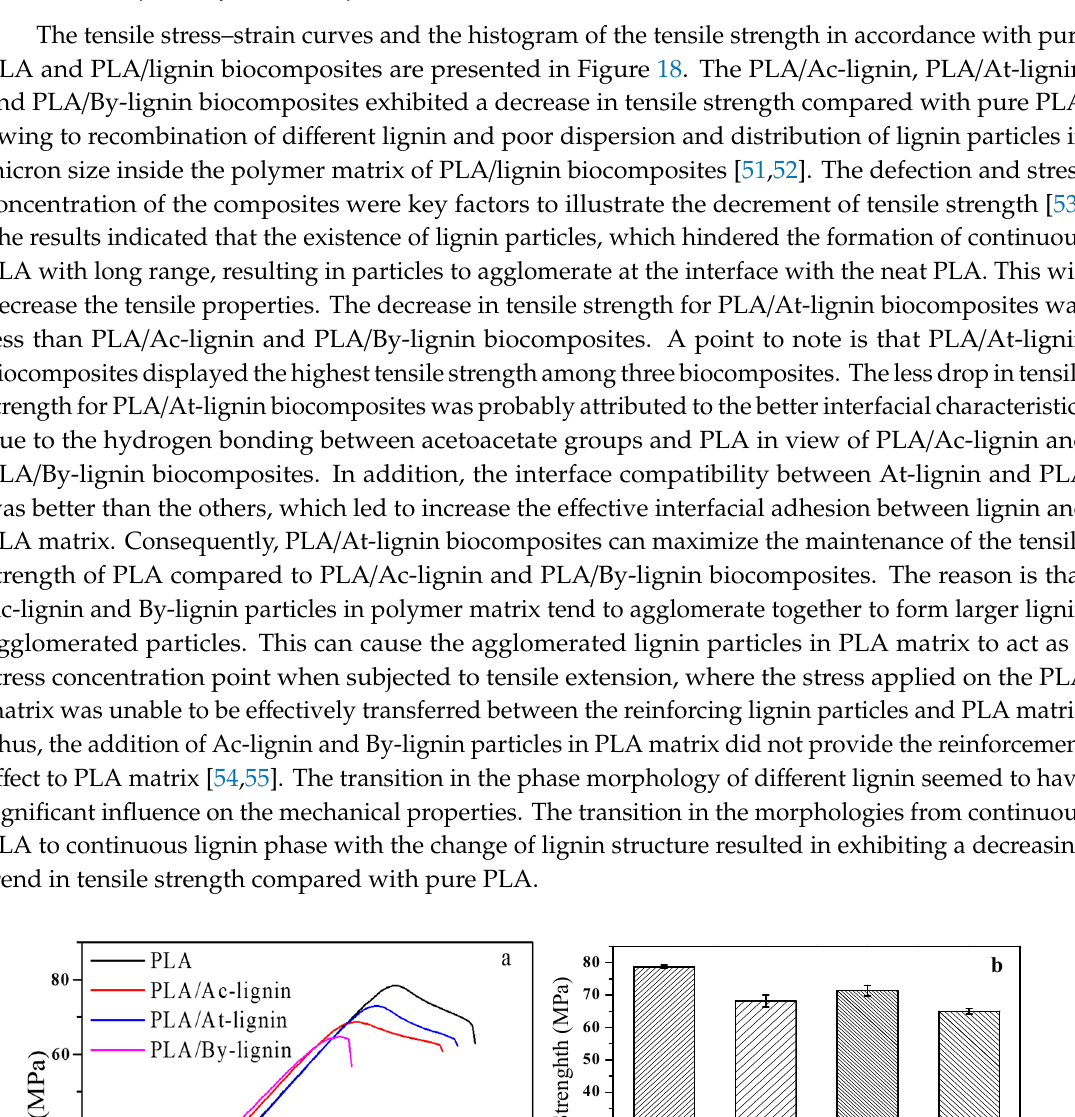
Figure 17. Temperature ramp sweep curves for pure PLA, PLA/Ac-lignin, PLA/At-lignin, and PLA/By-lignin biocomposites: ( a ) Storage modulus ( G ´), ( b ) loss modulus ( G ″ ), ( c ) complex viscosity ( η *).